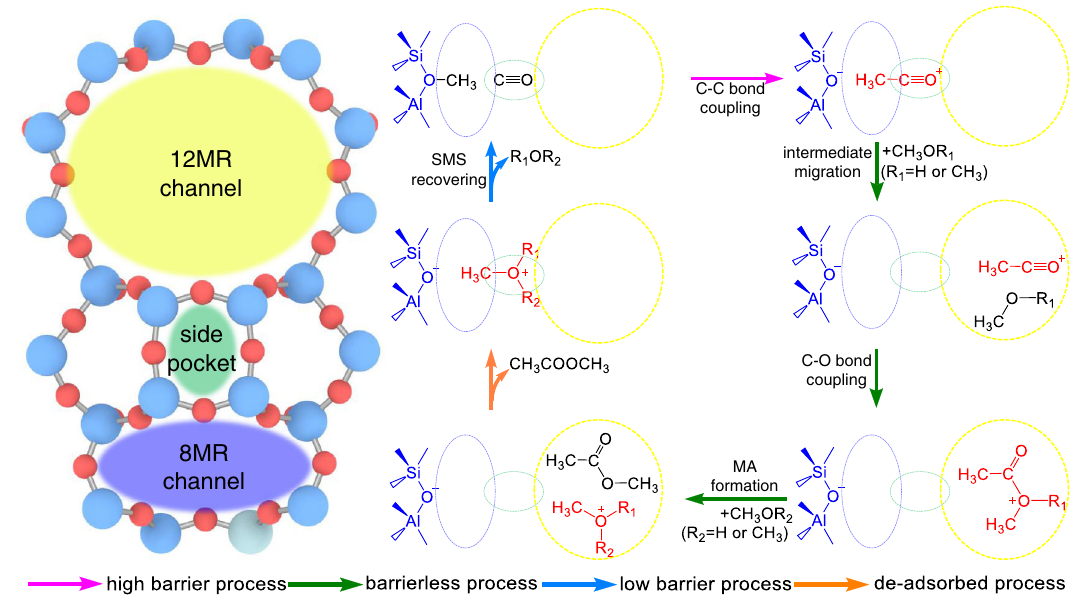
Fig. 5| Mechanismof DME/MeOHcarbonylationthrough thesynergisticactionof8MRchannels,sidepocket,and12MRchannelsinmordenitezeolite. Positively and negatively charged chemical species are depicted in red and blue, respectively.